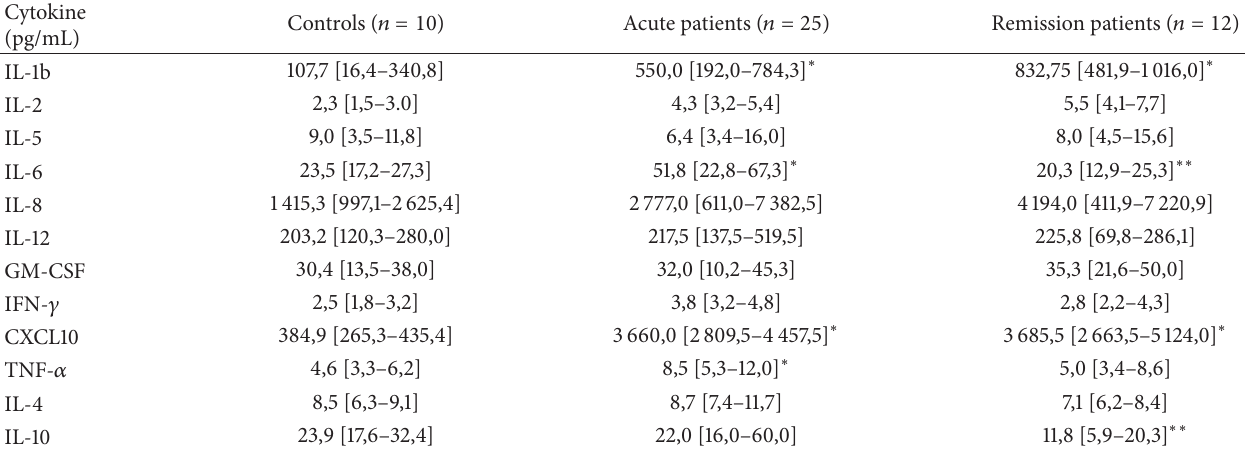
Table 1: Serum cytokine activation in juvenile CD (median [25th–75th percentile]).